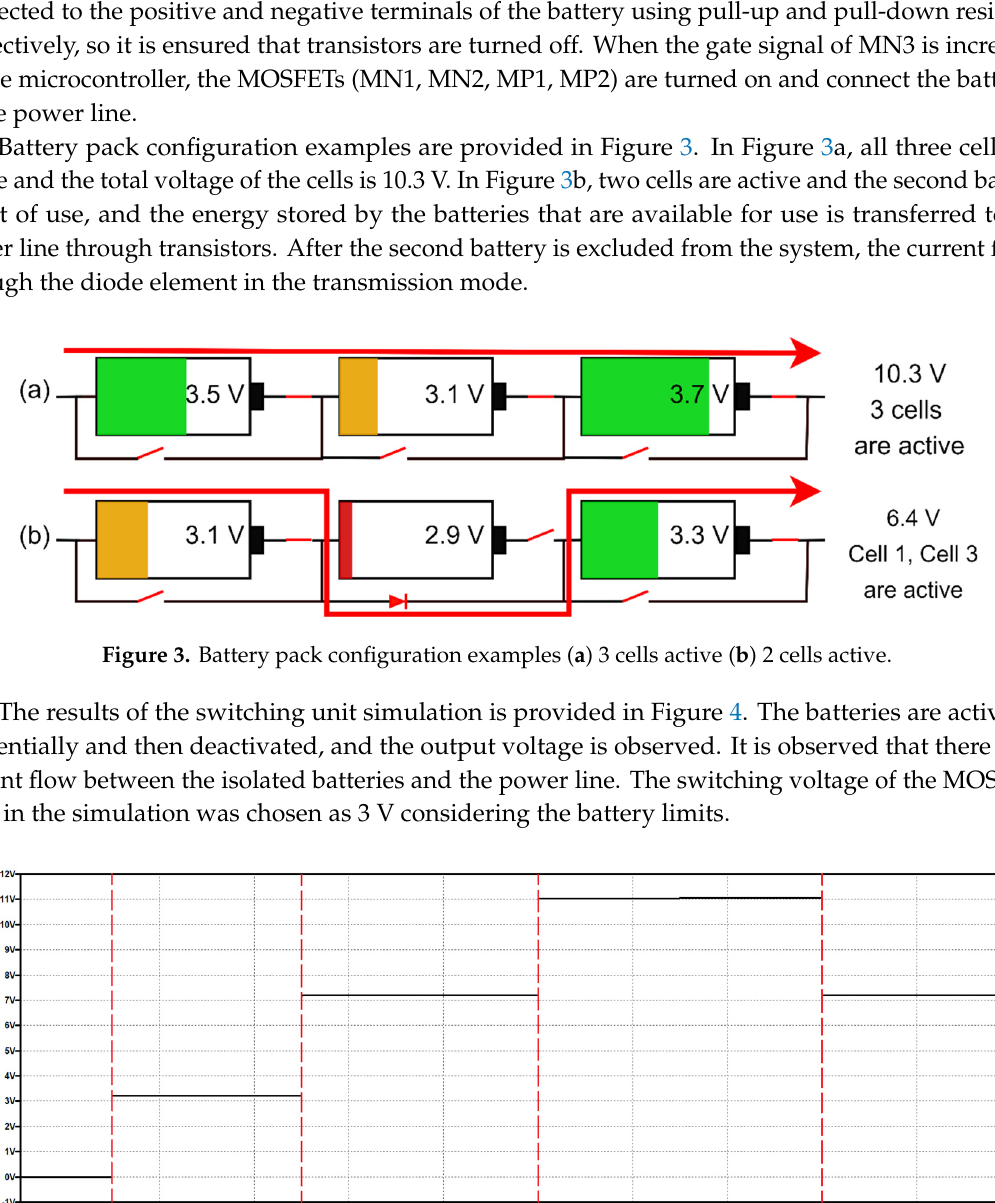
Figure 2. Schematic of the battery switching unit.